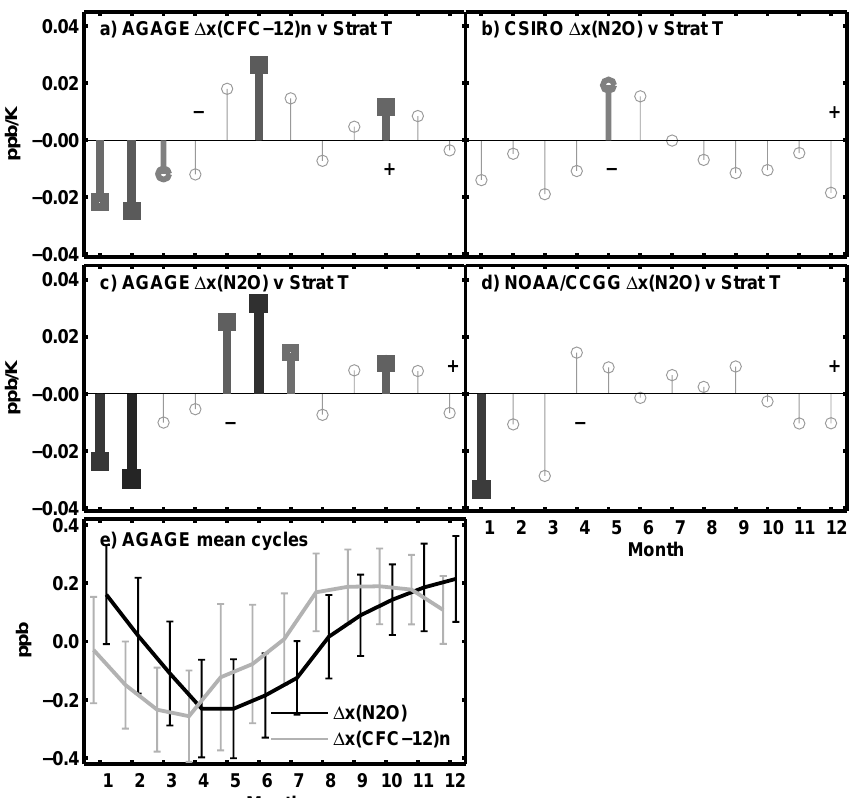
Fig. 10. Stem plots summarizing the linear regression slopes for detrended N 2 O or CFC-12 monthly means at Cape Grim vs. mean southern polar spring lower stratospheric temperature. Heavy lines indicate statistically significant correlations. The darker the line, the higher the R value: (a) AGAGE CFC-12, normalized by [ x (N 2 O)/ppb]/[ x (CFC-12)/ppt] and expressed in ppb units, (b) CSIRO N 2 O, (c) AGAGE N 2 O, (d) NOAA/CCGG N 2 O, (e) mean seasonal cycle for AGAGE N 2 O and normalized CFC-12, with error bars showing the standard deviation for each